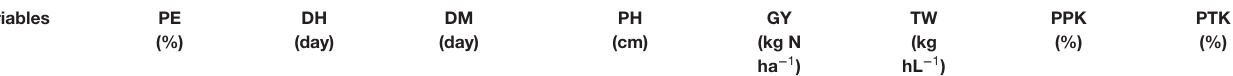
TABLE 12 | Pearson correlation for percent emergence, days to heading, days to maturity, plant height, grain yield, test weight, percent plump kernels, and percent thin kernels in Almota and Genesee.